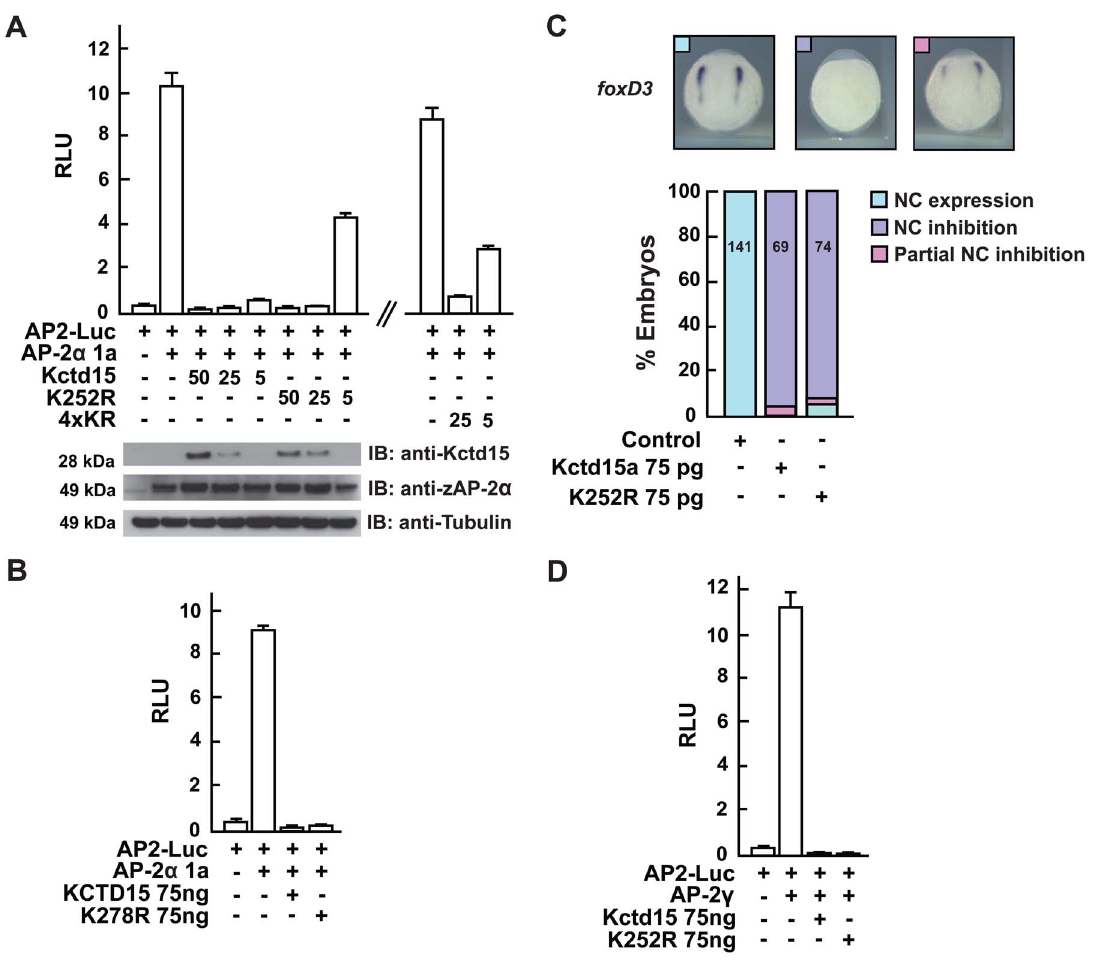
Figure 4. KR mutants repress AP-2 a function. (A) AP-2 a activity in a reporter assay [19] was inhibited by the K252R and 4xKR mutants with similar efficacy as the WT protein, although inhibition was reduced at low concentration. Immunoblots with anti-Kctd15, anti-AP-2 and anti-Tubulin antibodies control for protein expression. (B) AP2-Luc reporter assay using human KCTD15 and K278R mutant, both of which inhibit activity. (C) Kctd15 and K252R mRNAs were injected into zebrafish embryos. ISH with foxD3 probe at the 1 somite stage shows that the K252R mutant inhibits NC formation as effectively as WT Kctd15. Embryo images define normal expression, total inhibition and partial inhibition. Quantification is shown in the histogram, numbers of embryos listed on the bars. (D) Luciferase assay using AP-2 c illustrates that zebrafish WT and K252R mutant are equally effective in inhibiting reporter activity.